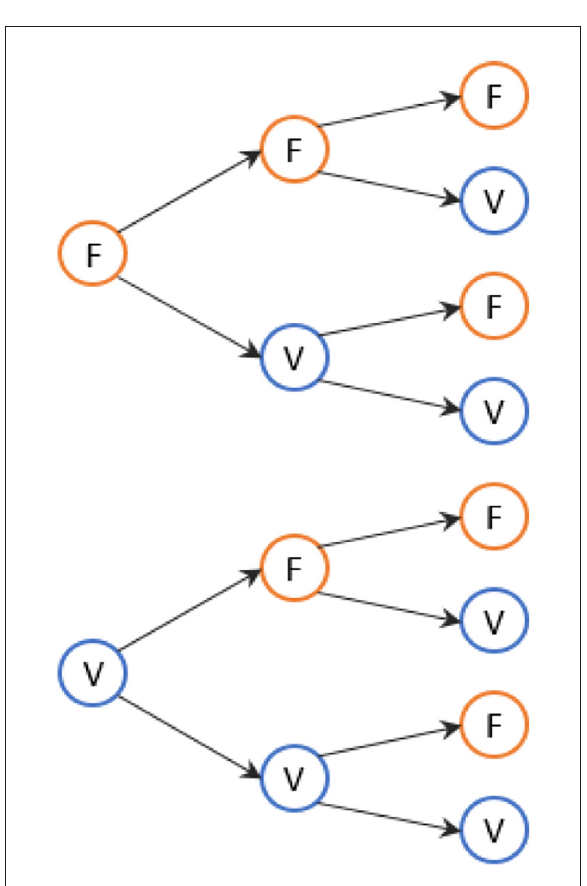
FIGURE3 Markov chain to analyse reaction time (RT) for three consecutive stimuli.